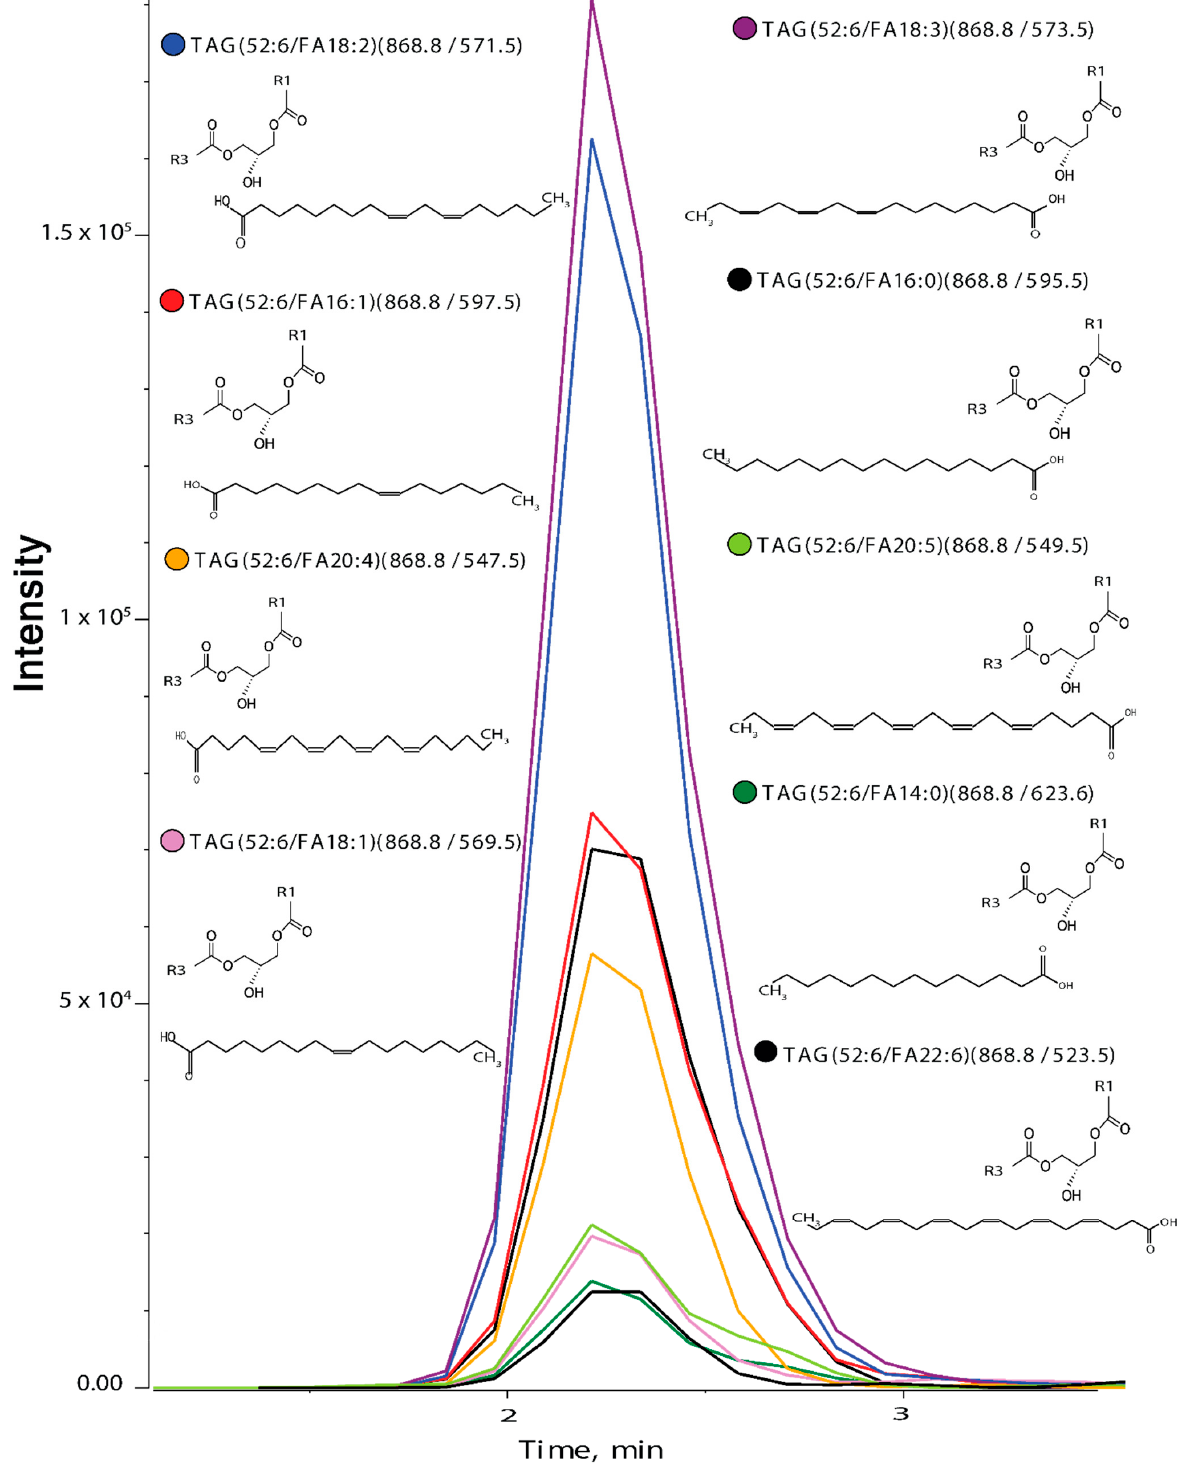
Figure 2. XIC (extracted ion chromatogram) of nine isomers of TAG (52:6). Parent m / z for all was 868.8 while the product m / z was derived from the remaining mass (R1 + R2 with glycerol backbone) after the loss of fatty acid released from the parent ion. R1 + R2 can be any composition of fatty acid which sum-up to give product ion. Different colored dots represent different isomers.